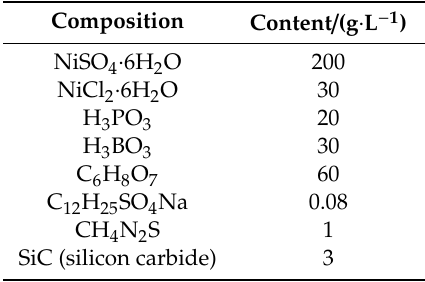
Table 2. Composition of the plating